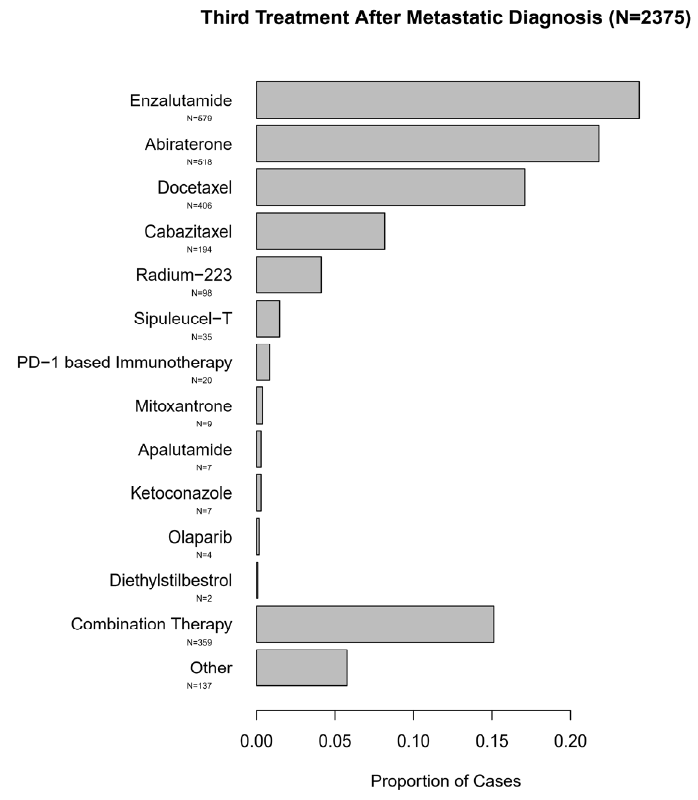
Figure 5. Third Treatment After Metastatic Diagnosis ( N = 2375).